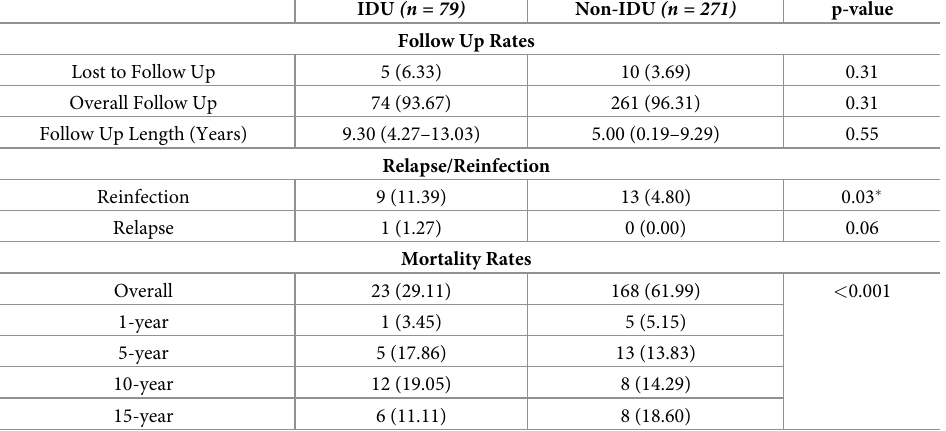
Table 4. Outcomes and follow up. All results except follow up length have been displayed as total number with per- centage proportion in brackets. Follow up length has been represented as median with IQR in brackets. Mortality rates have been displayed as number of deaths with percentage proportion of at risk population for time period in brackets. Statistical significance was determined using unpaired t-test for continuous variable, chi-square test for categorical var- iables with a sample size over five, and Fisher’s exact test for categorical variables with a sample size equal to or less than